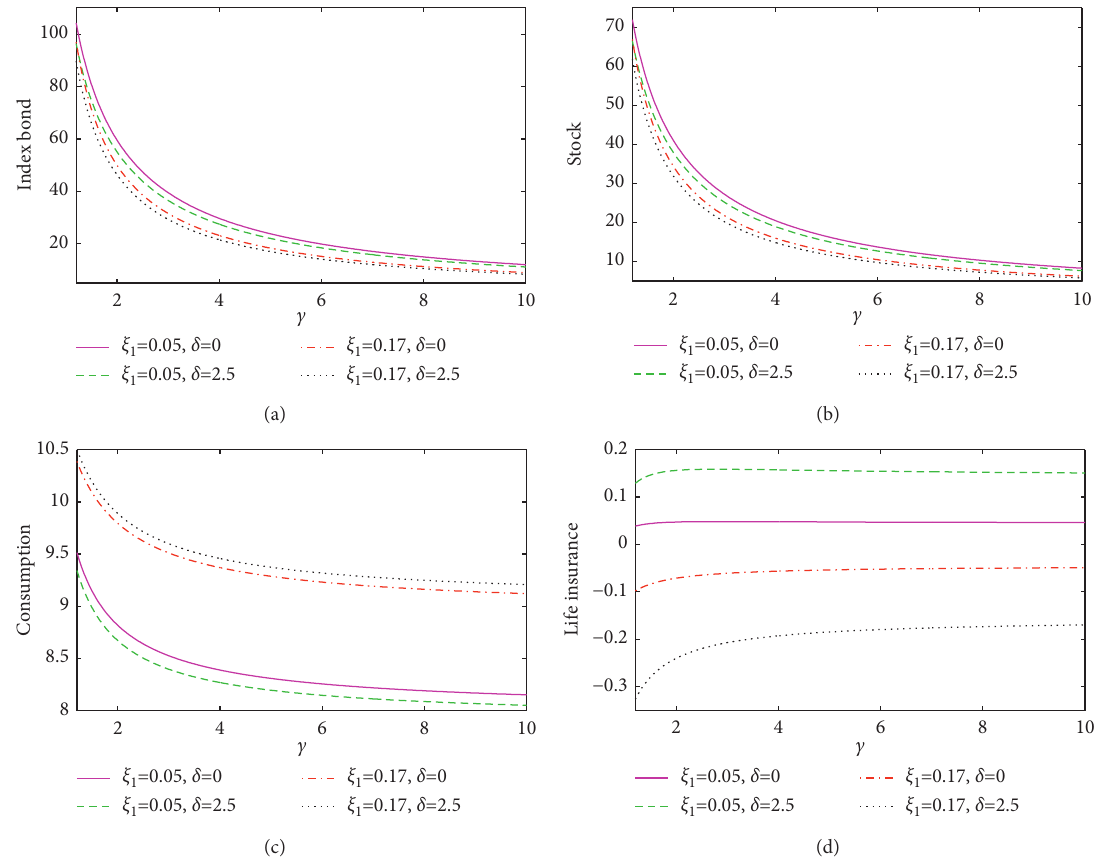
Figure 7: The effects of the relative risk aversion coefficient on the optimal